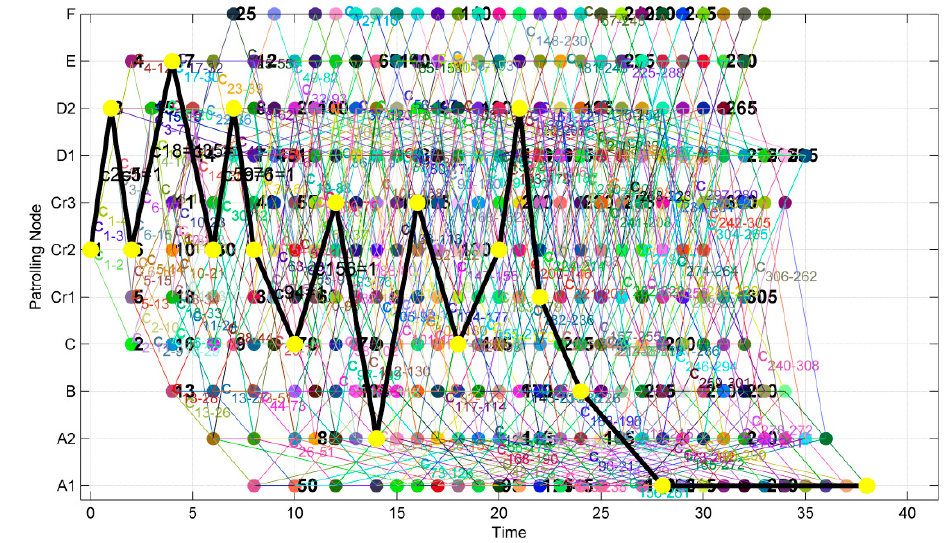
Figure 5. Optimal fixed patrolling route for a patrol team.